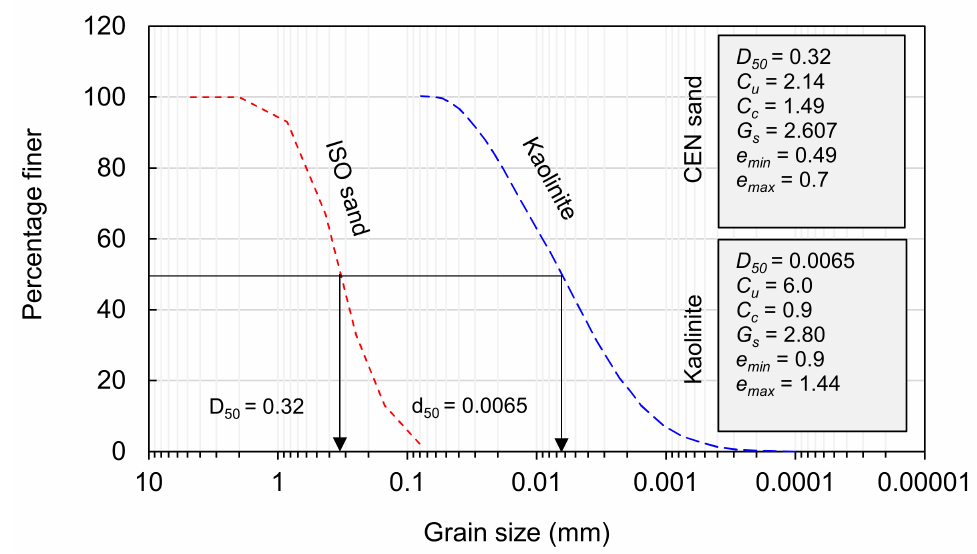
Figure 1. Grain size distribution of CEN standard sand and Kaolinite clay.